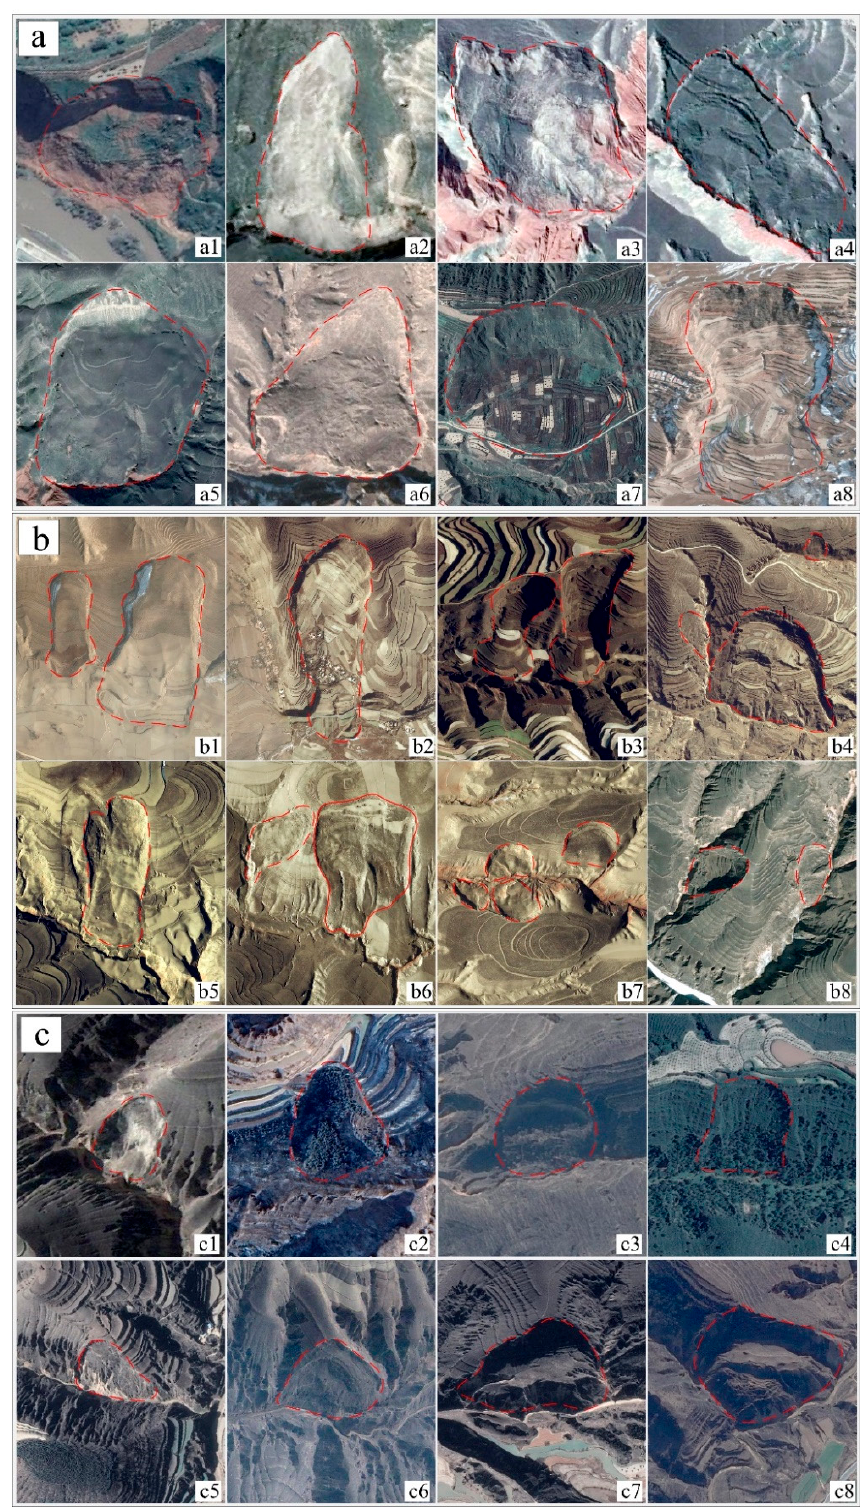
Figure 2. Samples of loess landslides. ( a ) Study site 1, a1—a3: the different forms of the new landslides; a4: the creep landslide; a5—a6: the unchanged ancient landslides; a7—a8: the ancient landslides. ( b ) Study site 2, b1—b8: the co ‐ seismic landslides changed by human activity induced by Haiyuan earthquake. ( c ) Study site 3, c1—c8: the landslides caused by gravity erosion and slope erosion.